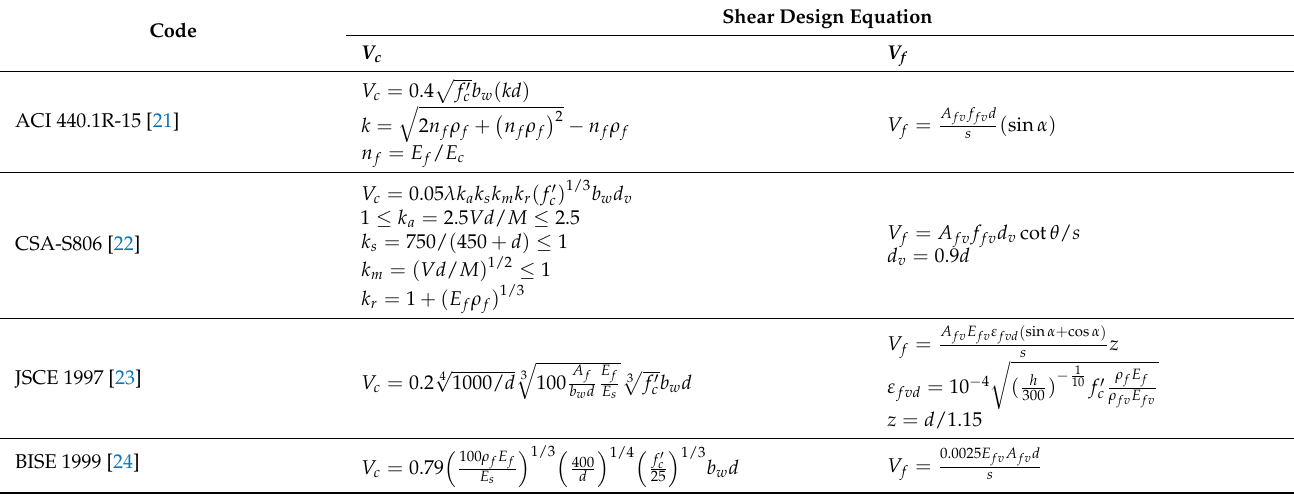
Table 4. Design equations for calculating shear capacity.